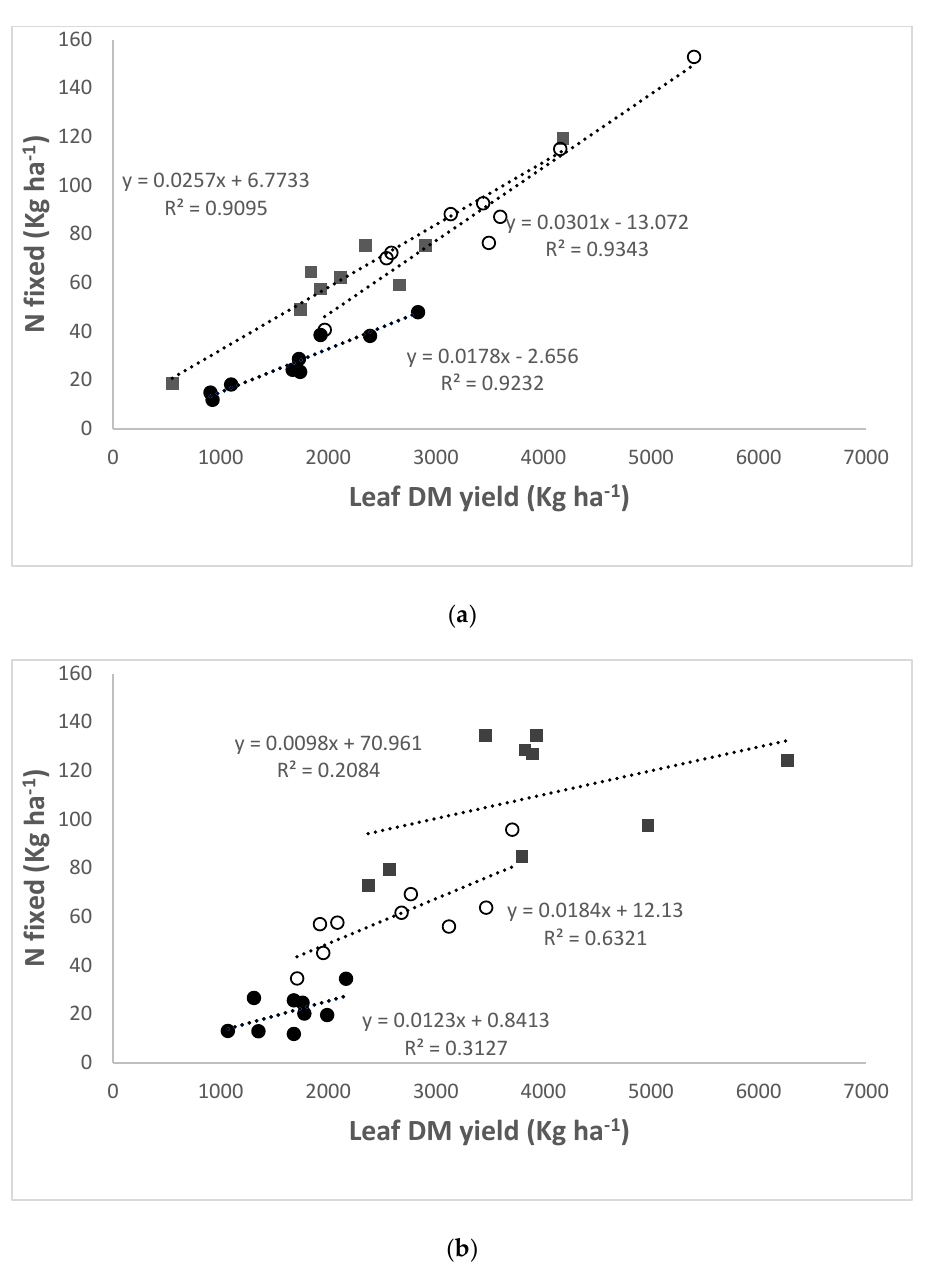
Figure 1. The relationship between fixed N and leaf dry matter yield in inoculated and unfertilized ( a ) or N100 fertilized ( b ) sulla plants. Black circles, black squares, and empty circles indicate leaf sampling carried out at vegetative, flowering, and seed set stage, respectively.